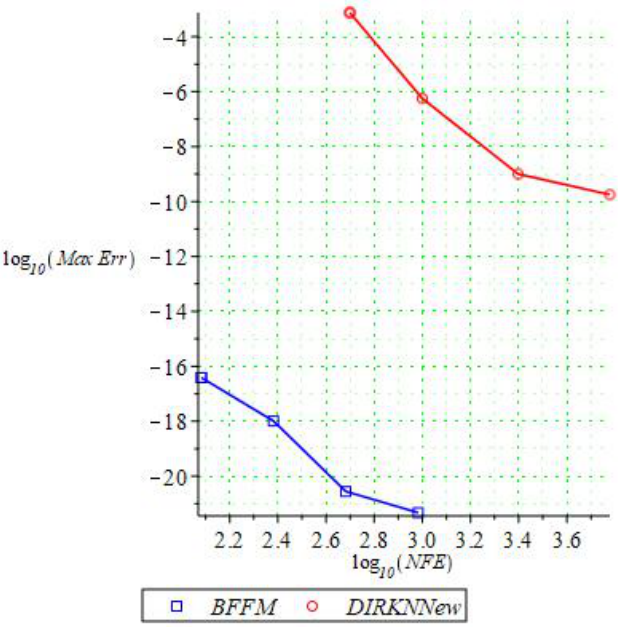
Figure 8. Efficiency Curves for Example